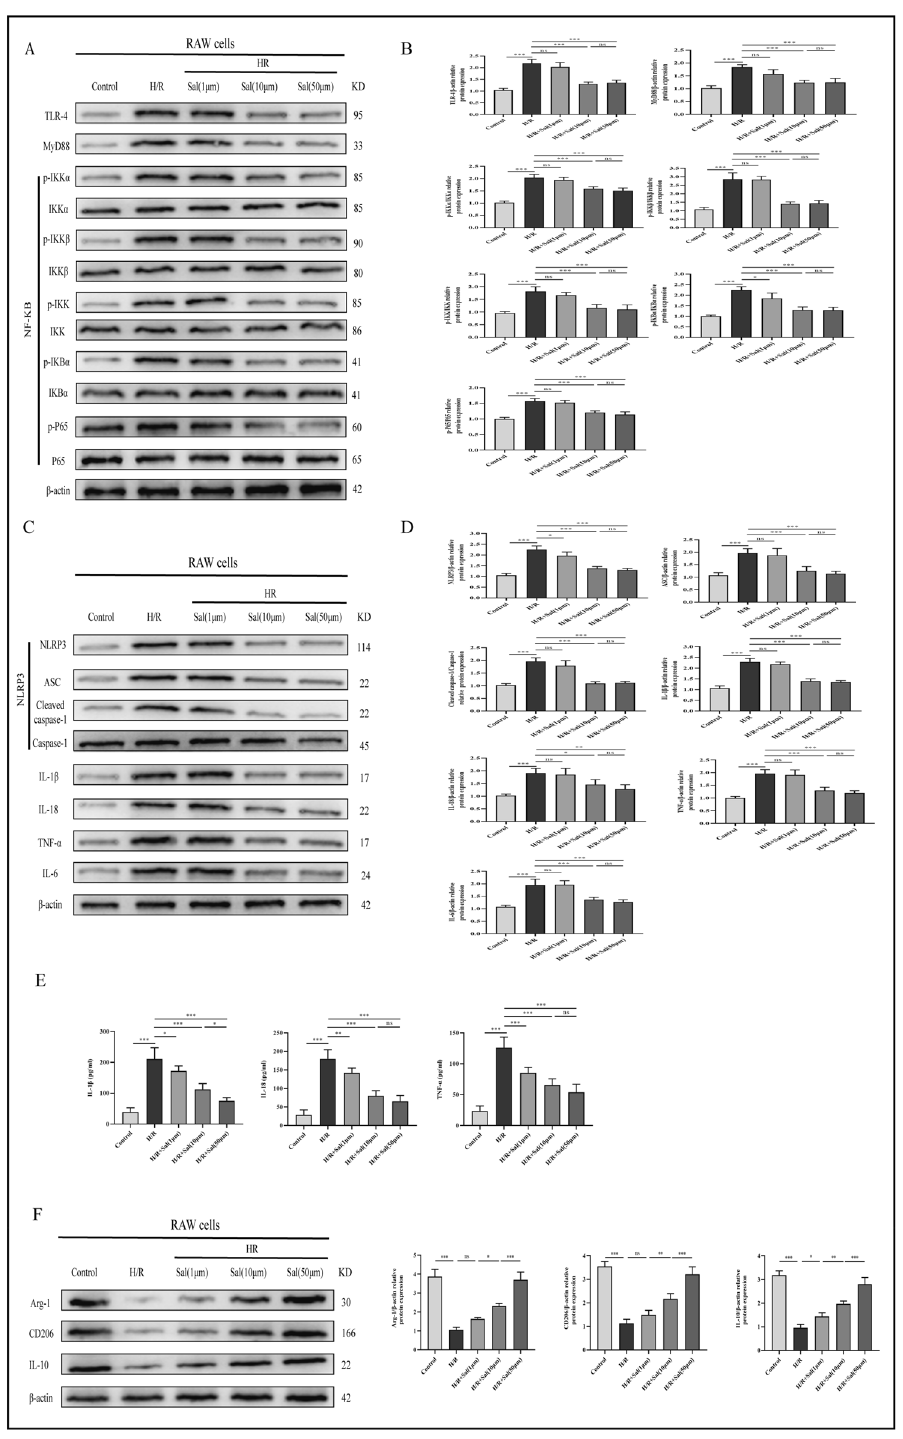
Figure 5. Salidroside inhibits inflammation in the H/R-exposed macrophages by regulating TLR-4/NF-κB/ NLRP3 inflammatory pathway. ( A , C ) Representative Western blot data showing TLR-4/NF-κB/NLRP3 inflammatory pathway associated proteins in macrophages. ( B , D ) The results of western blot experiments. ( E ) Expression of IL-1β, IL-18 and TNF-α in macrophages was analyzed by ELISA. ( F ) Expression of M2 polarization markers in macrophages was analyzed by western blot. The statistical differences among groups were assessed by one-way ANOVA. ns P > 0.05, * P < 0.05, ** P < 0.01, *** P <